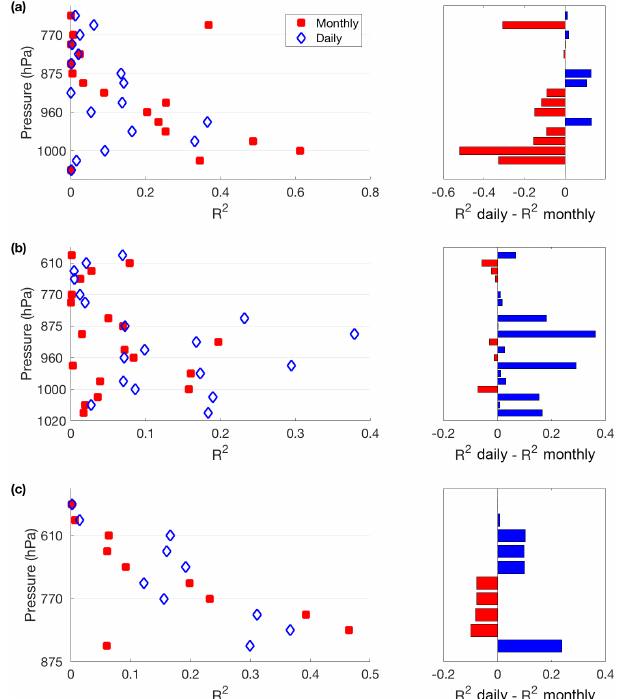
Figure 3. R 2 values for correlation between aircraft data and spa- tiotemporally matched WRF-Chem data for the (a) DISCOVER- CA, (b) DISCOVER-TX, and (c) DISCOVER-CO campaigns, binned by pressure. Left column shows absolute R 2 values for each bin. Right column shows the difference in R 2 values using monthly average and daily profiles for each